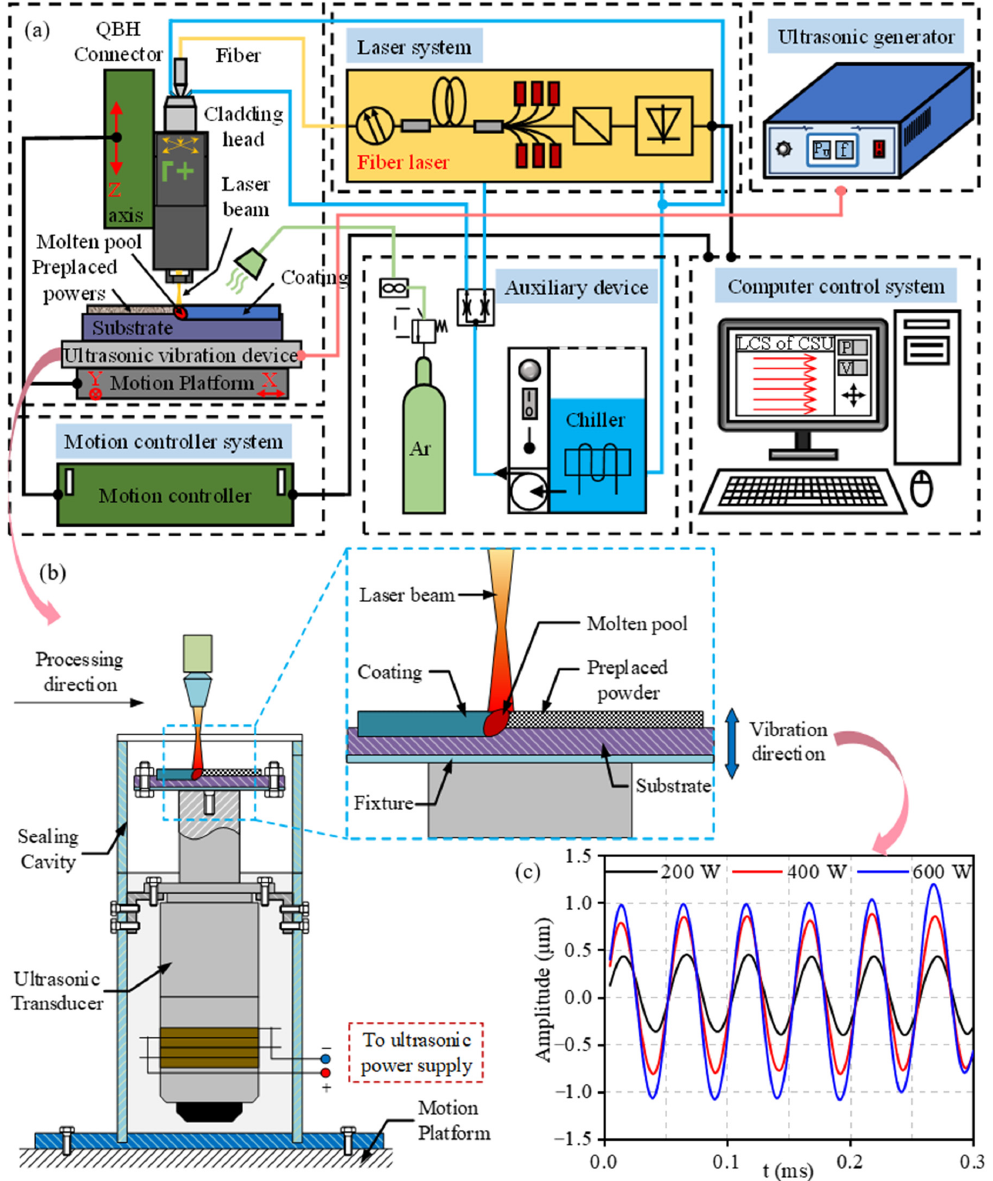
Figure 2. ( a ) Schematic diagram of ultrasonic vibration-assisted laser cladding system, ( b ) Schematic diagram of ultrasonic vibration device, ( c ) Ultrasonic vibration waveforms of substrate top surface with different ultrasonic vibration